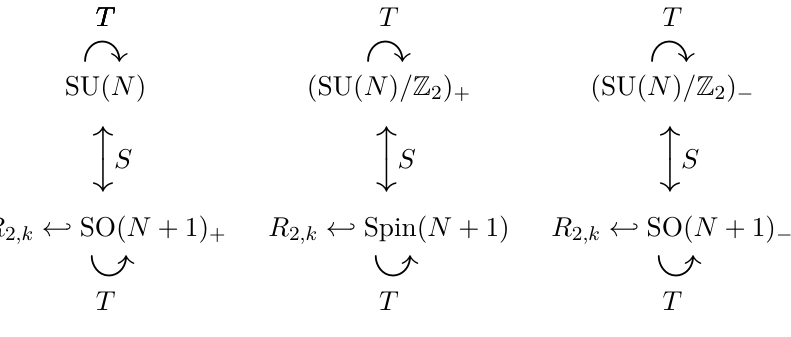
Figure 17. Duality orbits of the quiver (3.4) for N = 4 m